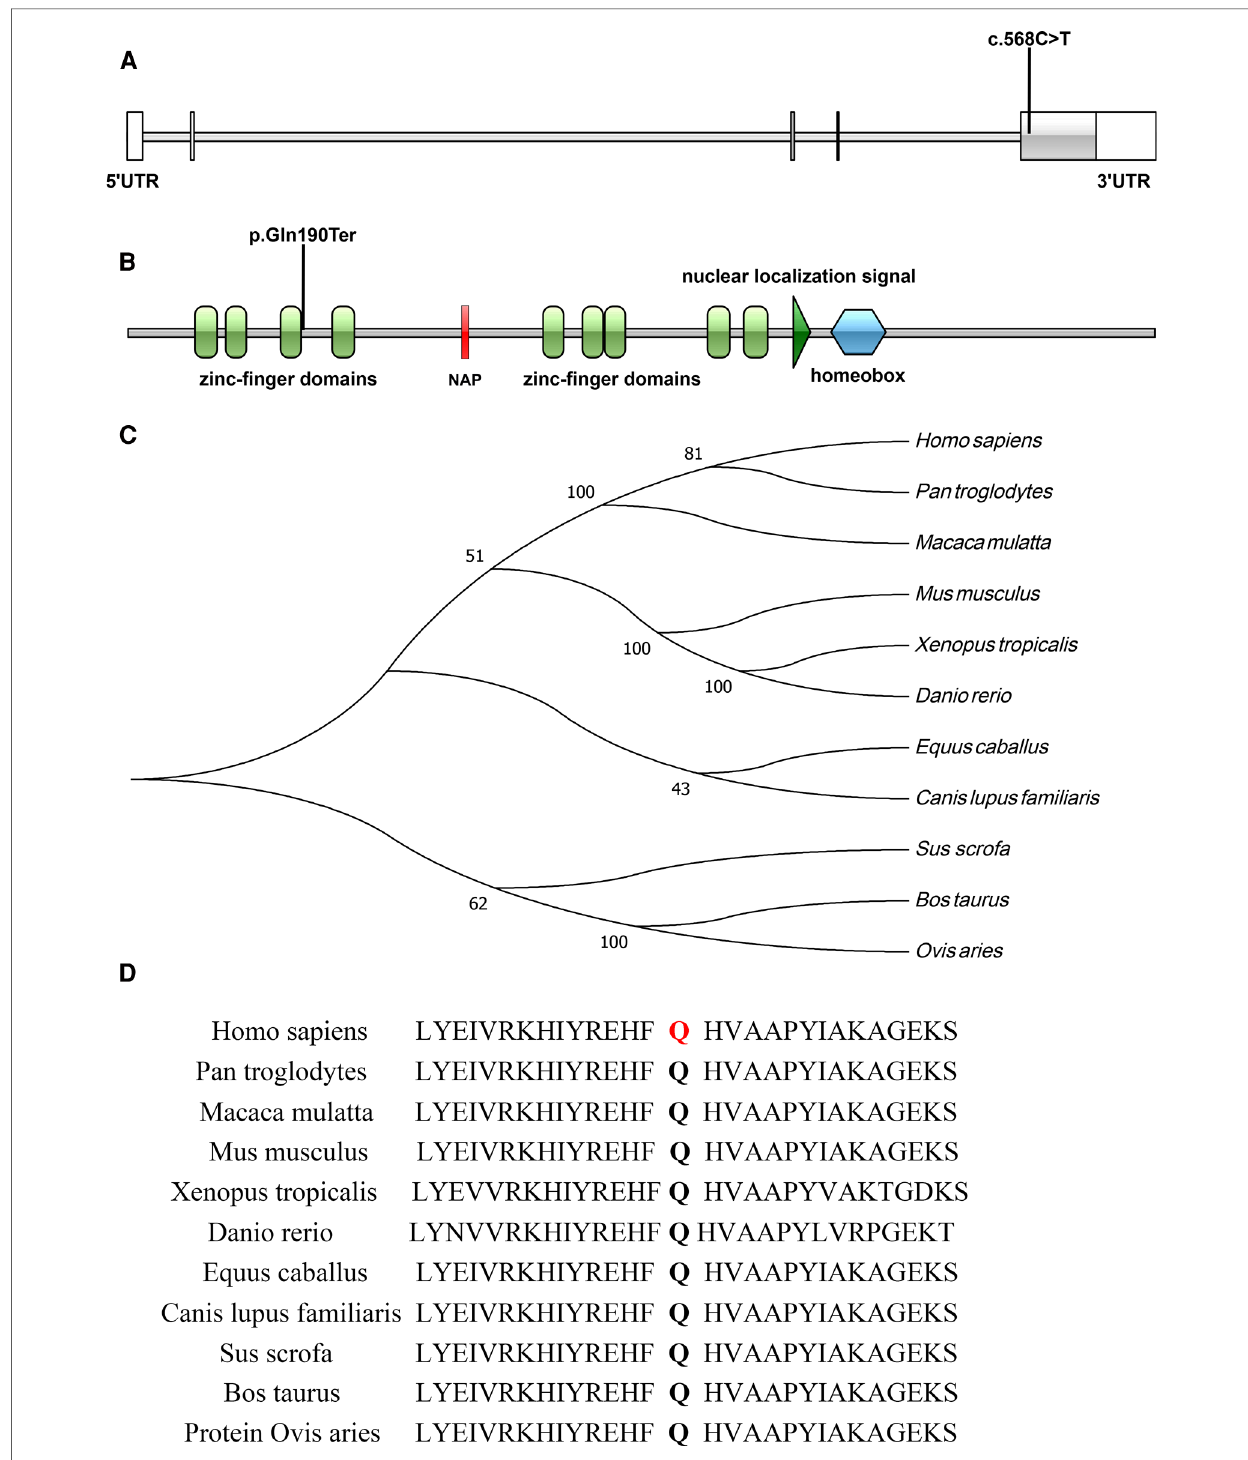
FIGURE 3 ( A,B ) Illustrations denoting the mutant sites, ( A ), nucleotide sequence; ( B ), protein sequence; ( C ) evolutionary relationships of species; ( D ) amino acid conservation in mutant